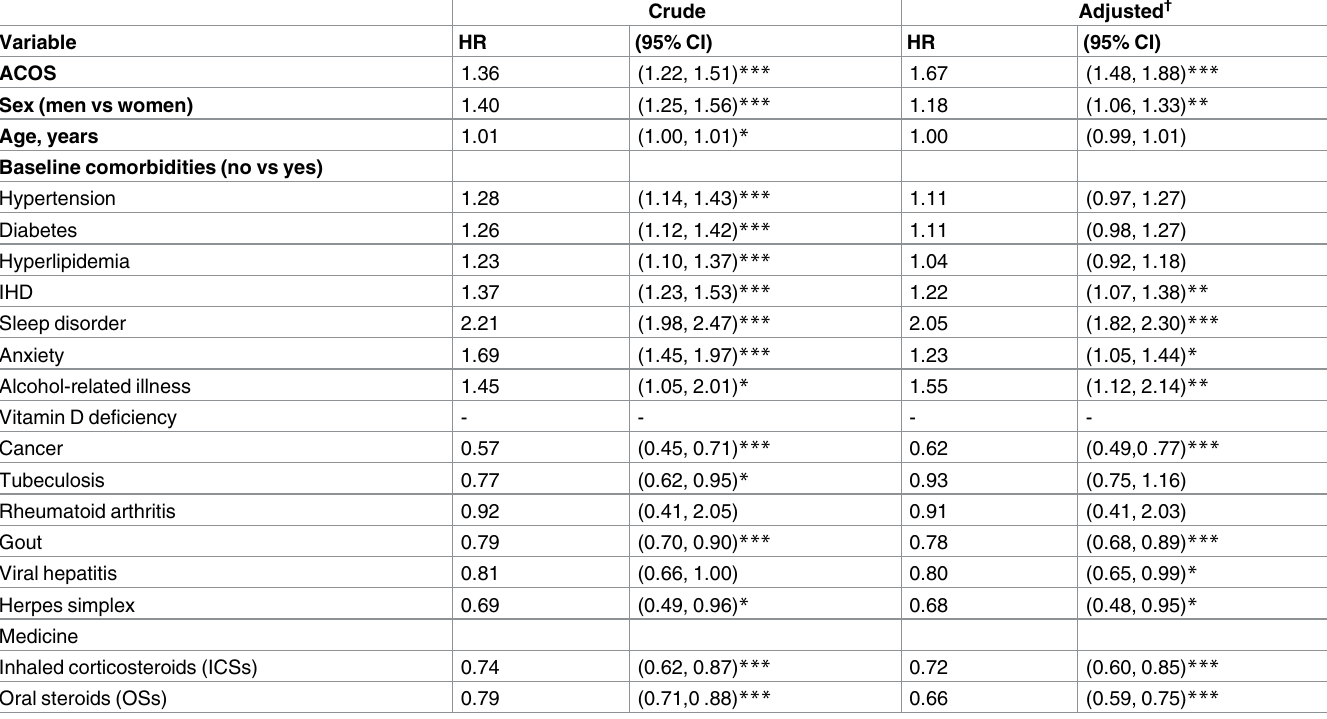
Table 4. HR of depression in Association with Sex, Age, and Comorbidities in Univariableand Multivariable Cox Regression Models.